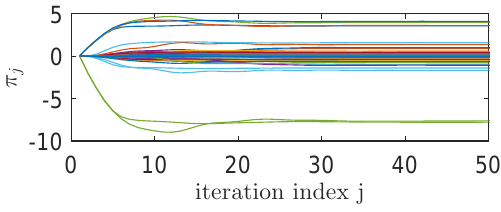
Figure 8. The LP-IMF-AVI parameters